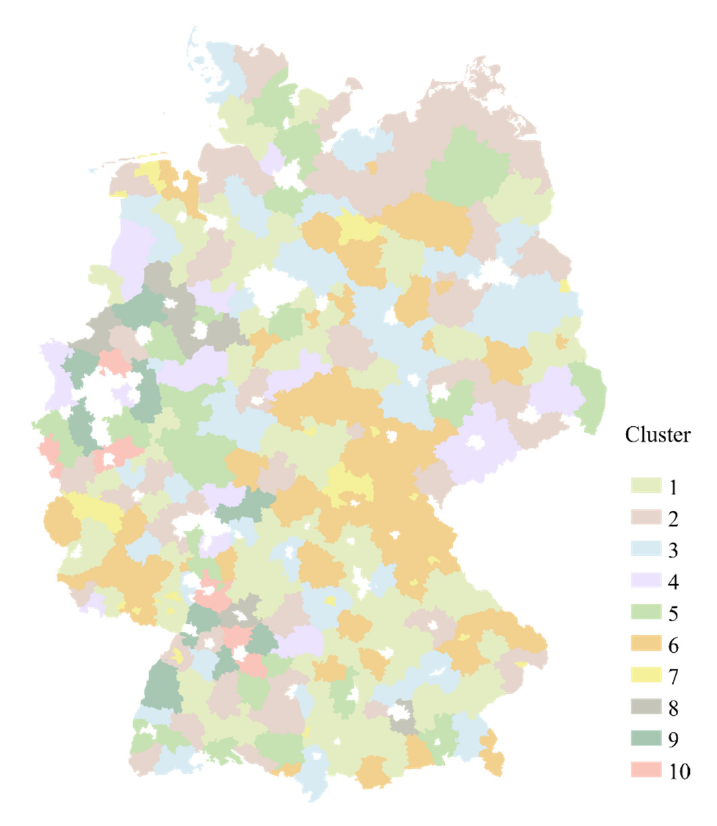
Figure 3. Spatial distribution of identified clusters.